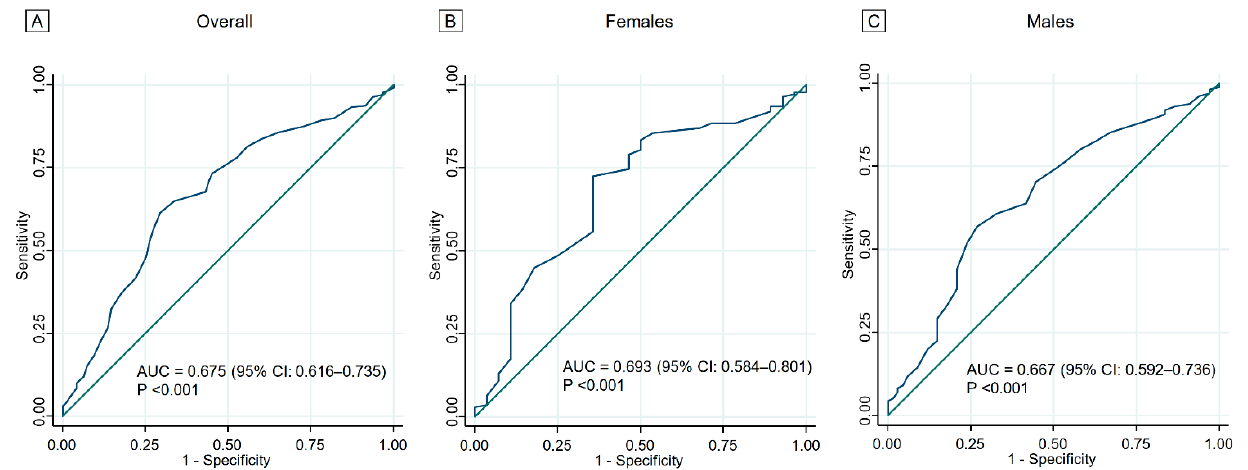
Figure 2. Receiver-operating characteristic curves of the FAI. The cut-off values of the FAI score for all-cause mortality were 23 points in the overall cohort ( A ), 22 points in females ( B ), and 23 points in males ( C ). AUC, area under the curve; FAI, Frenchay Activities Index.